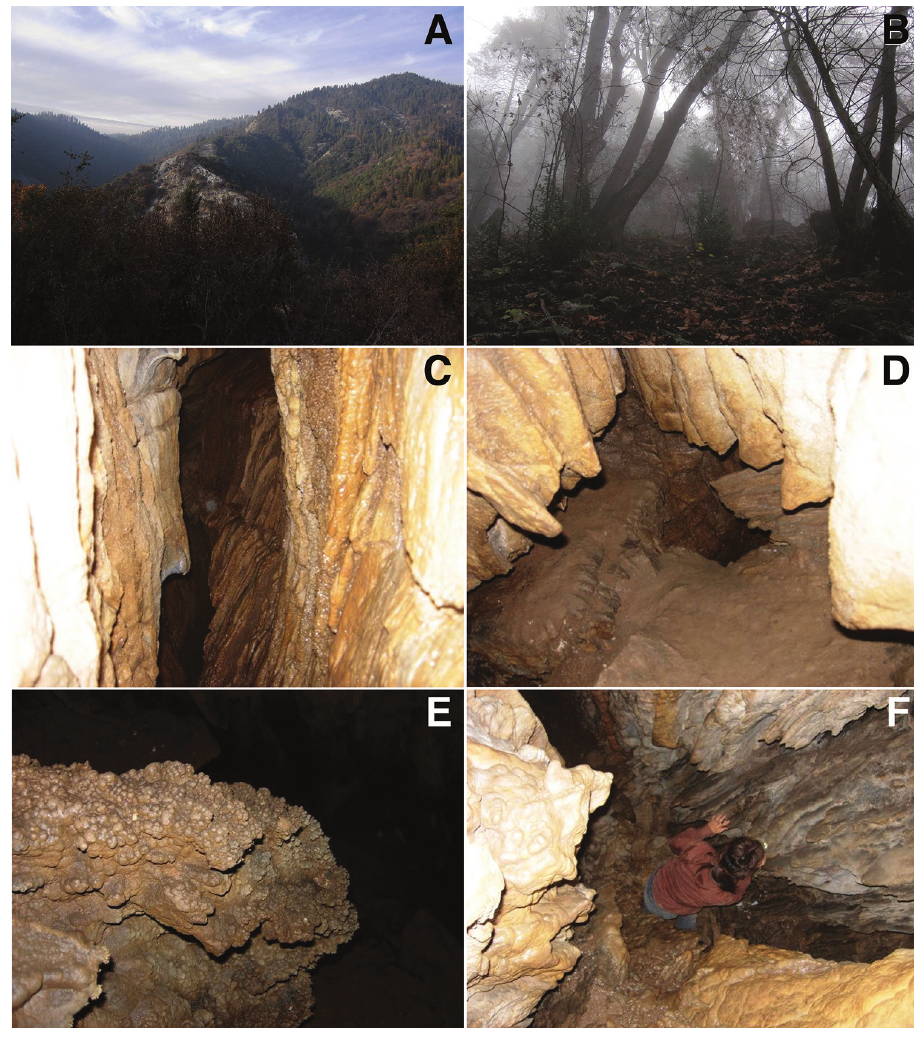
Figure 20. Habitat of I. tobini sp. n.: A Yucca Ridge, Sequoia National Park, California, with marble rocks exposed along ridge (center) B Woodland habitat on north facing slope of Yucca Canyon C–F Interior of marble